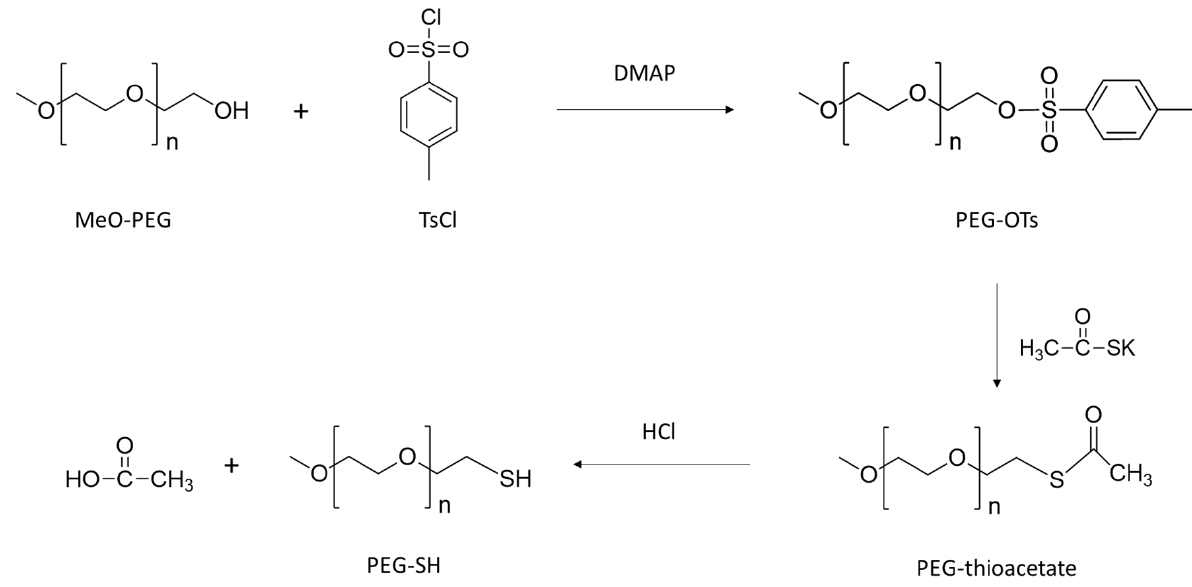
Figure 5. Synthesis of PEG-SH.